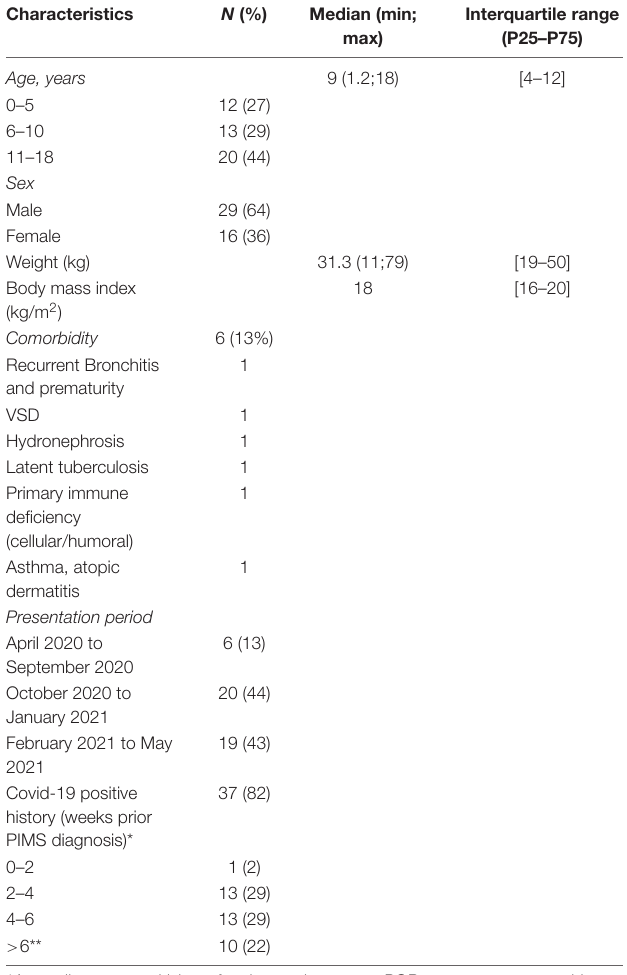
TABLE 1 | Demographic